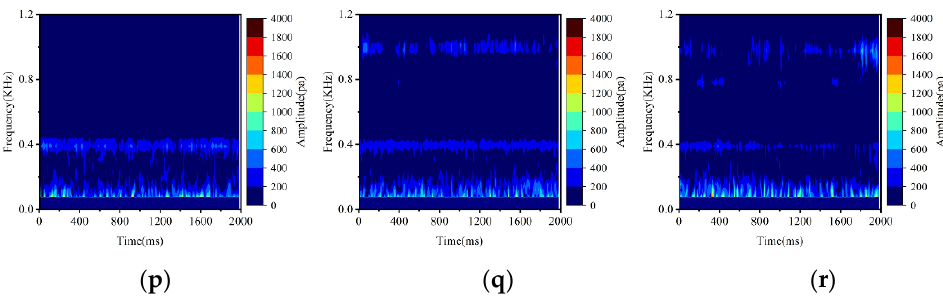
Figure 7. Time–frequency domain of pressure pulsation for three volutes at different positions. ( a ) p1 at single-tongue volute; ( b ) p1 at double-tongue volute (static); ( c ) p1 at double-tongue volute (rotate); ( d ) p2 at single-tongue volute; ( e ) p2 at double-tongue volute (static); ( f ) p2 at double-tongue volute (rotate); ( g ) p3 at single-tongue volute; ( h ) p3 at double-tongue volute (static); ( i ) p3 at double-tongue volute (rotate); ( j ) p4 at single-tongue volute; ( k ) p4 at double-tongue volute (static); ( l ) p4 at double-tongue volute (rotate); ( m ) p5 at single-tongue volute; ( n ) p5 at double-tongue volute (static); ( o ) p5 at double-tongue volute (rotate); ( p ) p6 at single-tongue volute; ( q ) p6 at double-tongue volute (static); ( r ) p6 at double-tongue volute (rotate).